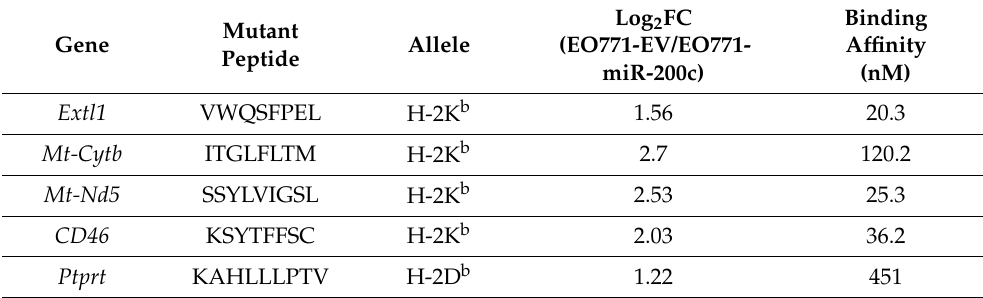
Table 1. SNV-derived peptides selected for CD8 + T cell immunogenicity assays. Mutant Gene Peptide